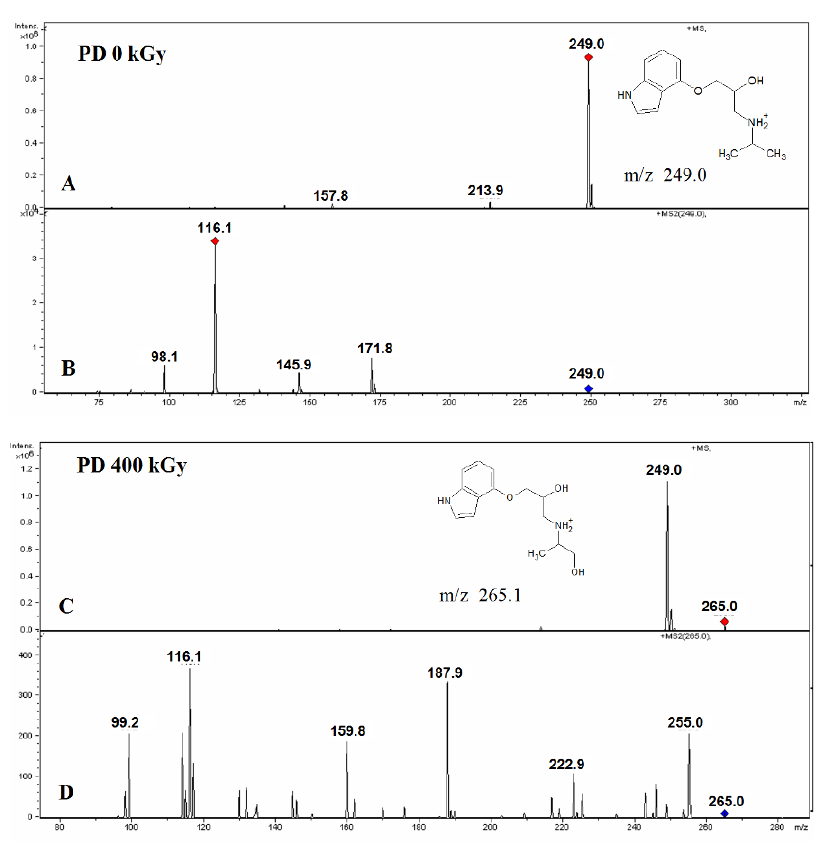
Figure 5. MS spectra of PD after chromatographic separation (HPLC) (A) and its main product of radiolytic degradation after irradiation with 400 kGy (C); (B), (D) – further fragmentation of molecular ions of PD and the main product of its radiolytic degradation.